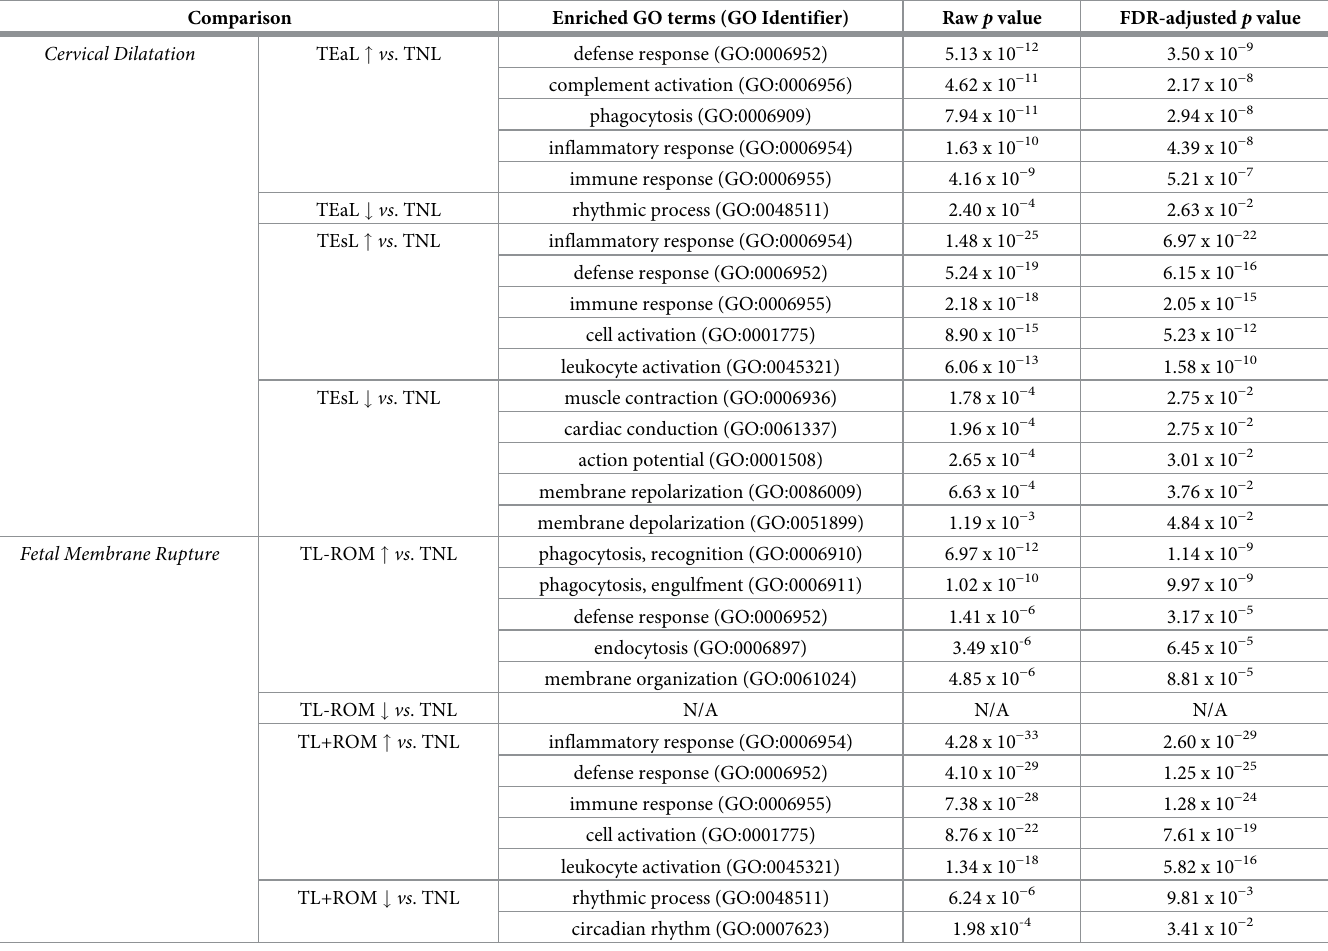
Table 6. Top five enriched gene ontology (biological processes) terms for human myometrium in different labour states.